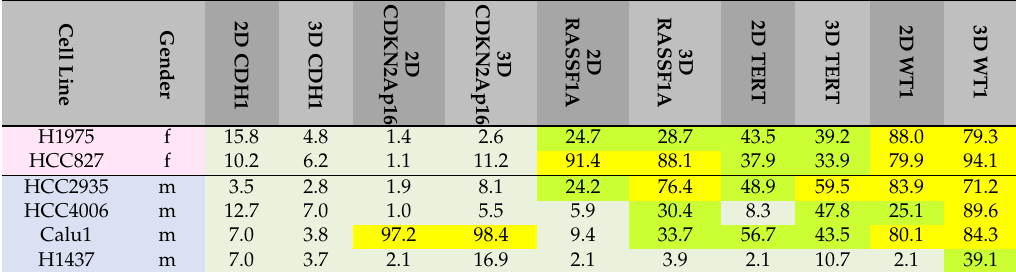
Table 3. Di ff erence in promoter methylation in the cell lines cultured in 2D versus 3D methlyation increased significantly in HCC827 cells in the gene CDNKA2p16 ( p = 0.005), in HCC2935 cells in the genes CDNKA2 p16 ( p = 0.000) and RASSF1A ( p = 0.008), in HCC4006 cells in the genes CDNKA2p16 ( p = 0.000), RASSF1A ( p = 0.000), TERT ( p = 0.000), and WT1 ( p = 0.000), in Calu1 cells in the